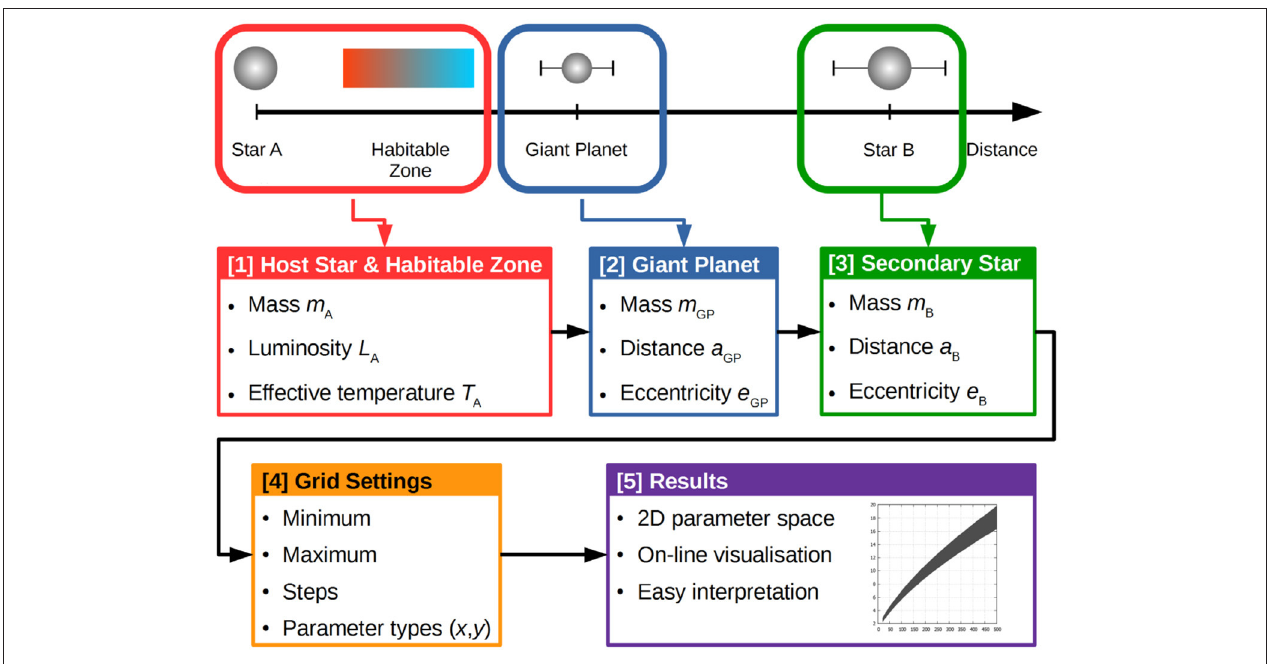
FIGURE 2 | Flow chart of the online tool SHaDoS